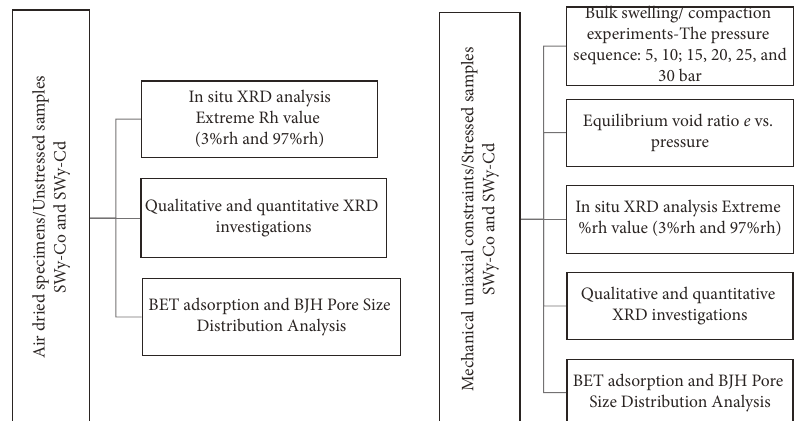
Figure 1: Experimental process of the mechanical constraint details, the in situ XRD analysis, and the porosity